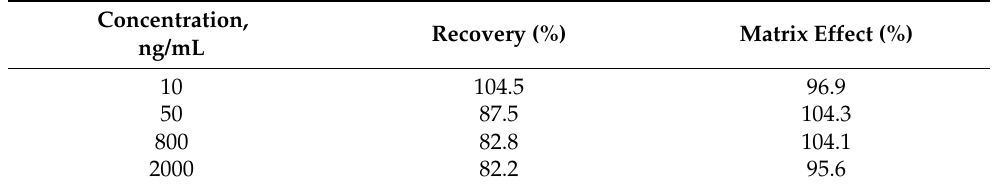
Table 2. Recovery and the matrix